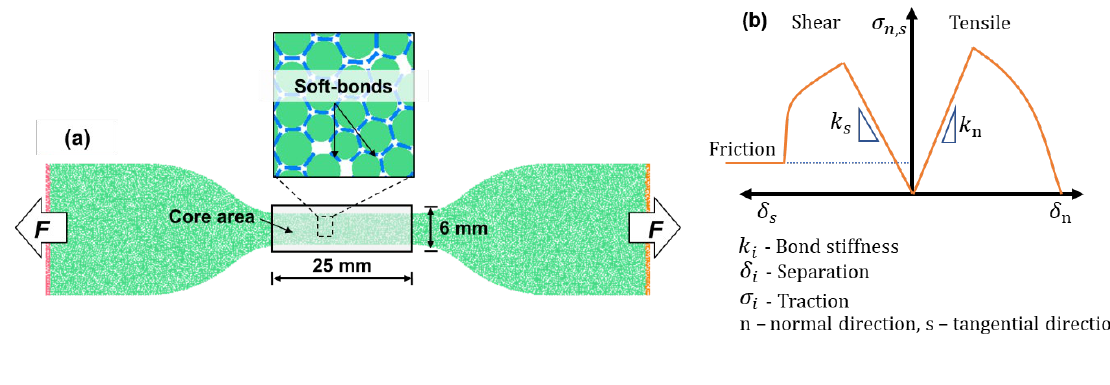
Fig. 1: Dogbone shaped interlayer specimen and adopted contact